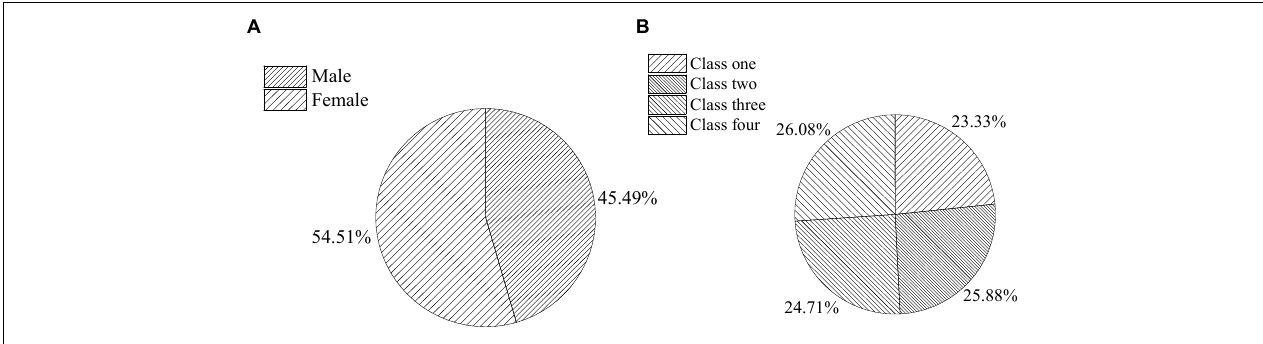
FIGURE 5 | Basic information of the experimenters ( A , ratio of genders; B , ratio of classes).